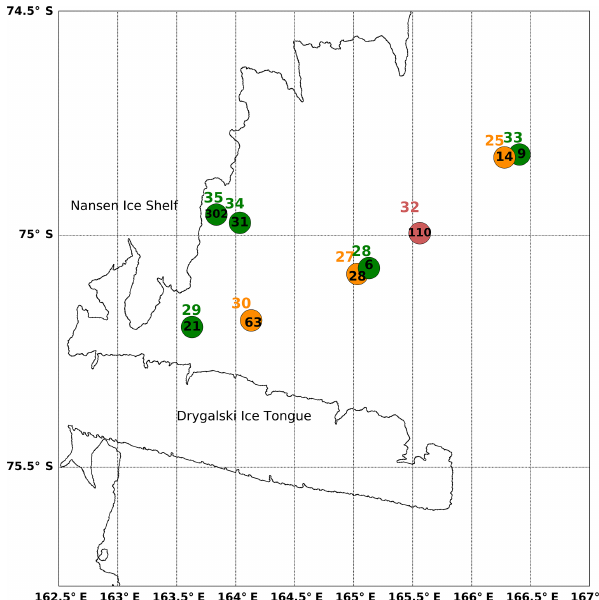
Figure 10. Map of TNBP CTD stations with anomalies and ice pro- duction rates. The CTD station number is listed to the north of the stations. The value inside the circle is the ice production rate (at that station) in centimeters per day. The symbols and station num- bers are colored by wind speed: green indicates wind speeds less than 10ms − 1 (Stations 28, 29, 33, 34, 35), orange indicates wind speeds between 10 and 15ms − 1 (Stations 25, 27, 30), and red indi- cates wind speeds over 15ms − 1 (Station